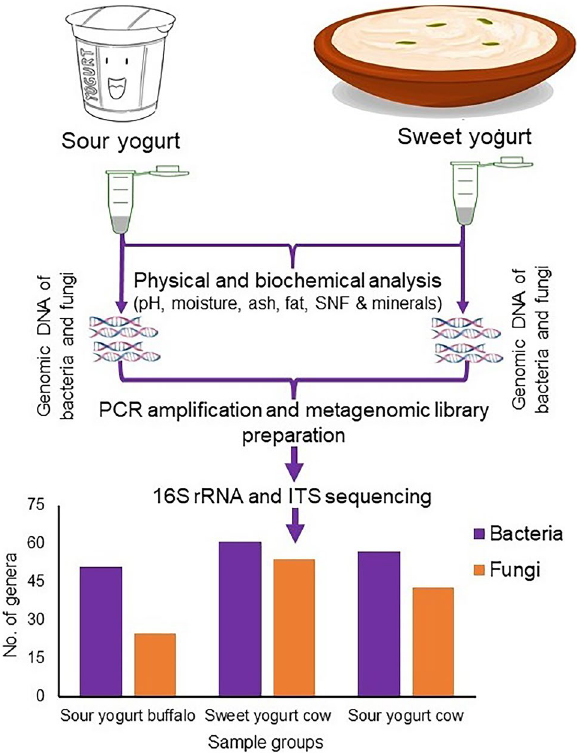
Figure 1. Schematic representation of nutritional and microbiome study in sweet and sour yogurt samples produced from cow and buffalo milk manufactured by seven reputed brands in Bangladesh.